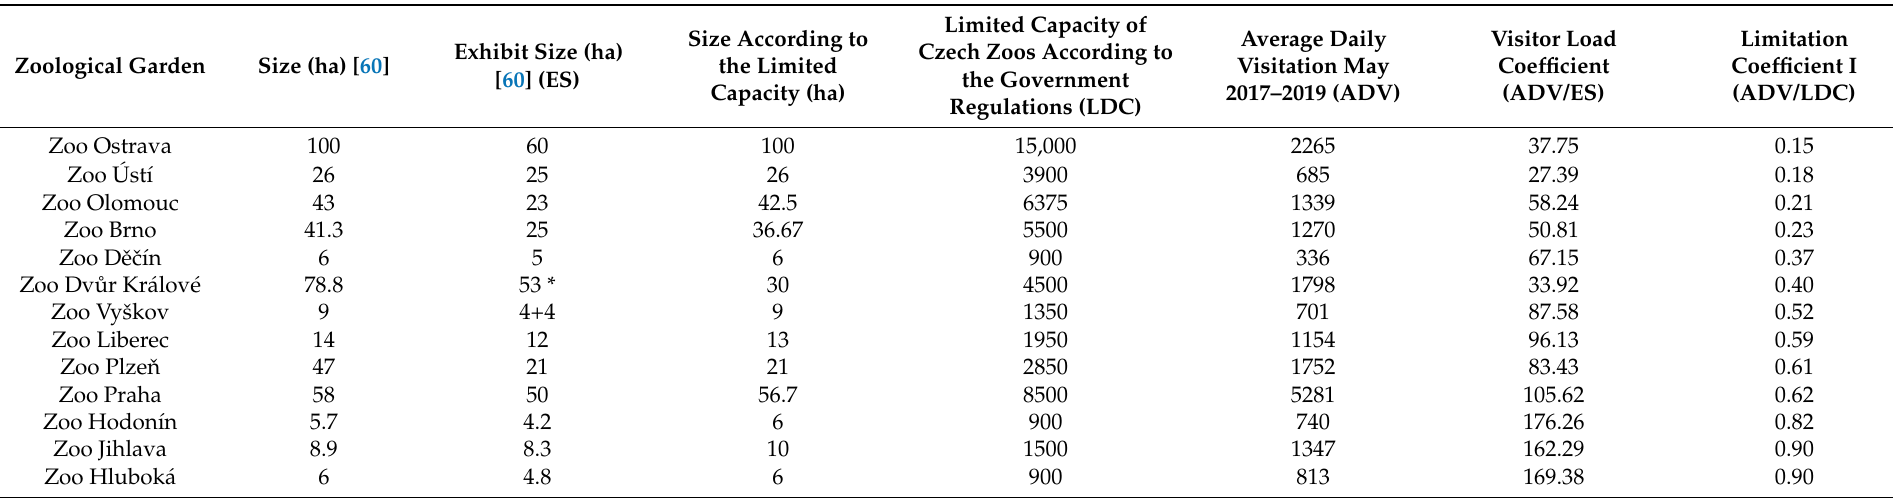
Table 2. Figures on the Size and the Facility Capacity of selected Czech Zoos According to the Government Regulations ( N = 13; sorted by ADV/LDC; * pedestrian + safari parts).